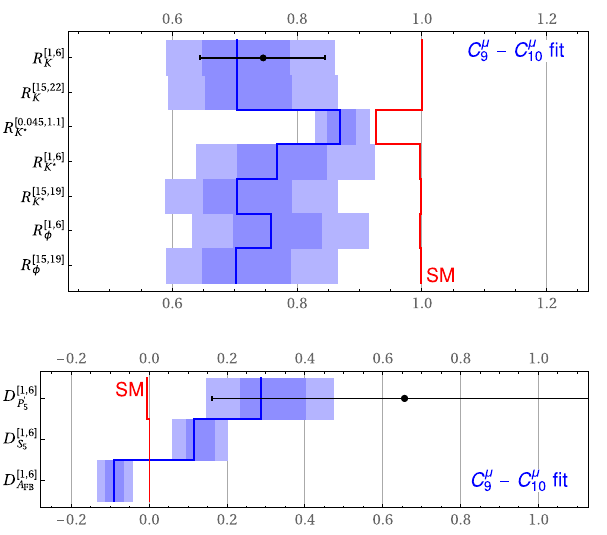
in GeV 2 . The red lines show the SM predictions. The 1 σ and 2 σ ranges in the NP scenarios are shown in blue . In black the LHCb measurement of R K and the Belle measurement of D P (cid:4)